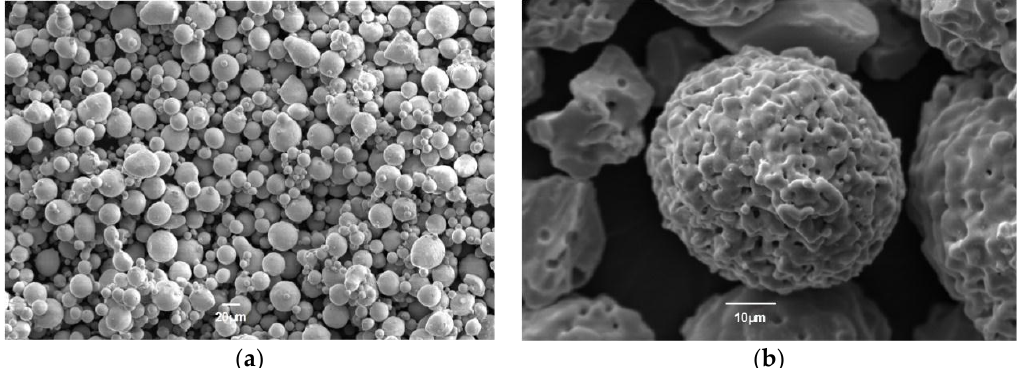
Figure 1. Morphologics of powders: ( a ) NiCoCrAlYTa and ( b ) 7YSZ.